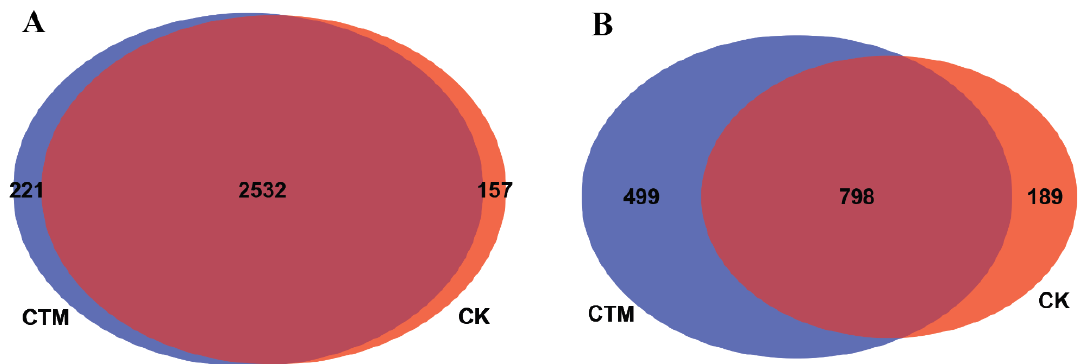
Figure 5. Venn diagram analyses of soil bacterial ( A ) and fungal ( B ) communities demonstrating the numbers of shared and unique observed OTUs at 97% similarity.